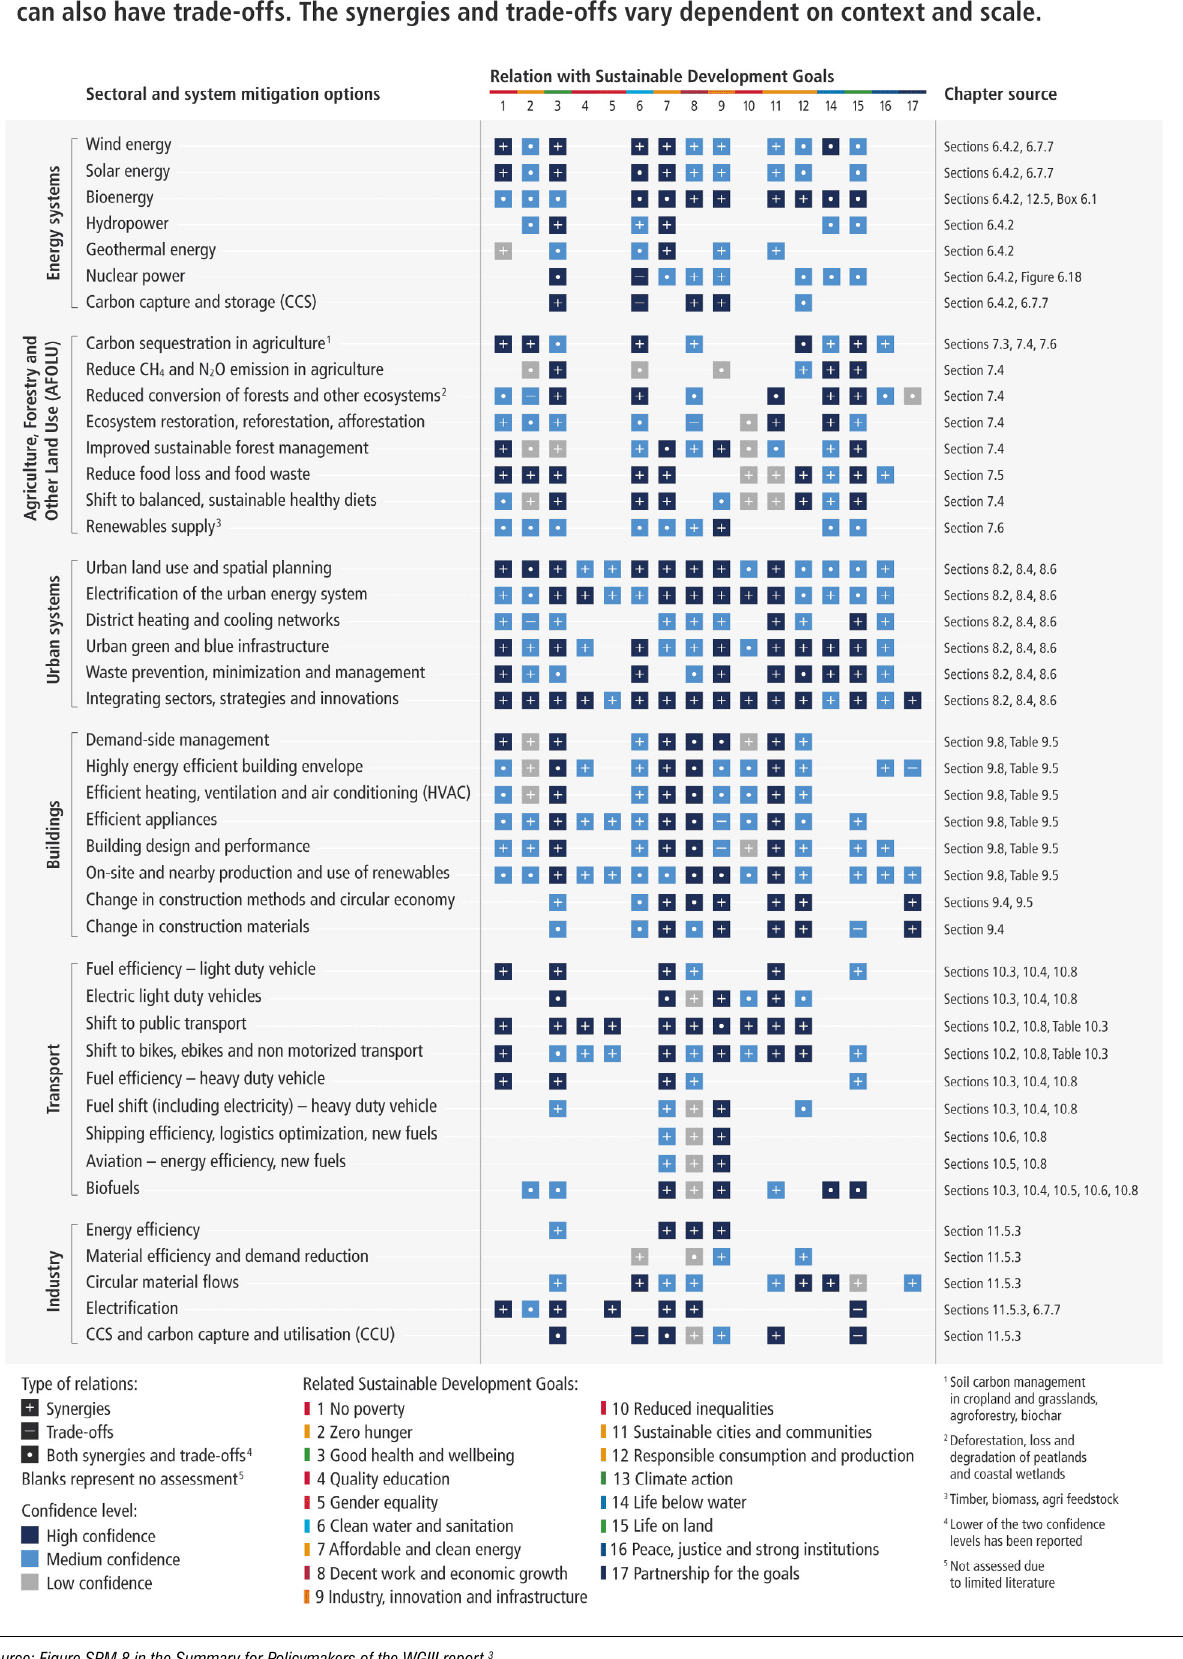
Source: Figure SPM.8 in the Summary for Policymakers of the WGIII report. 3 Figure 1: Synergies and trade-offs between sectoral and system mitigation options and the